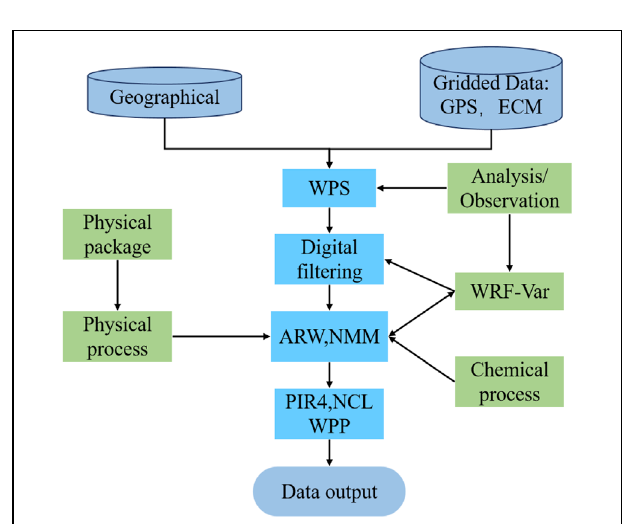
FIGURE 2 | The flow chart of WRF